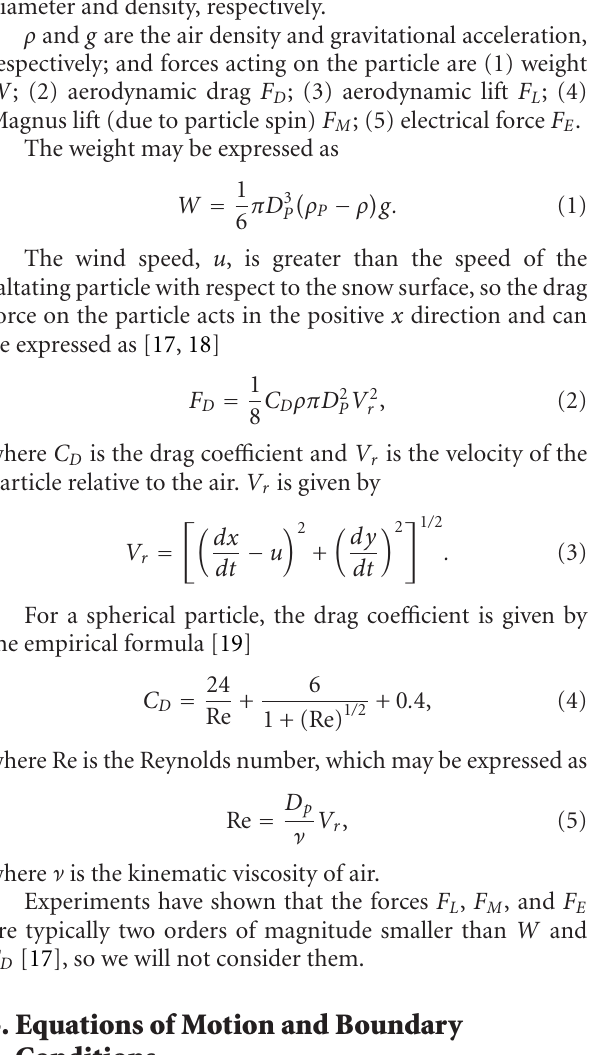
wind flows in the positive x direction and where y is the particle height above the bed. D P and ρ P are the snow particle diameter and density,